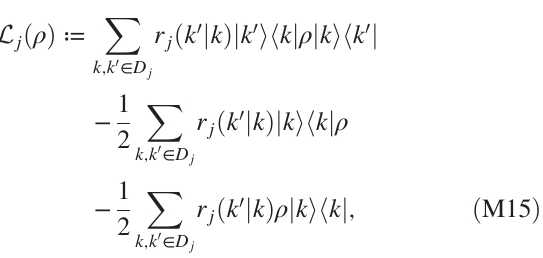
f ð t Þ − t= ð β ℏ Þ ∈ ½ 0 ; 50 (cid:2) j